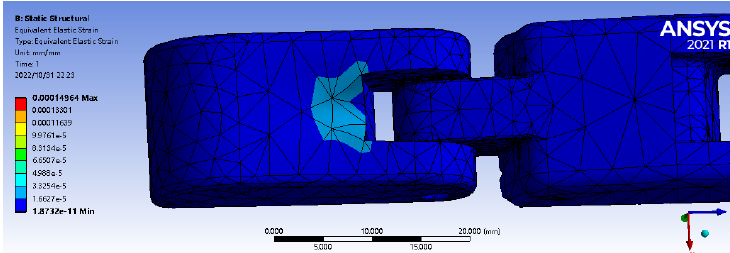
Figure 6. Simulation model of robot finger.